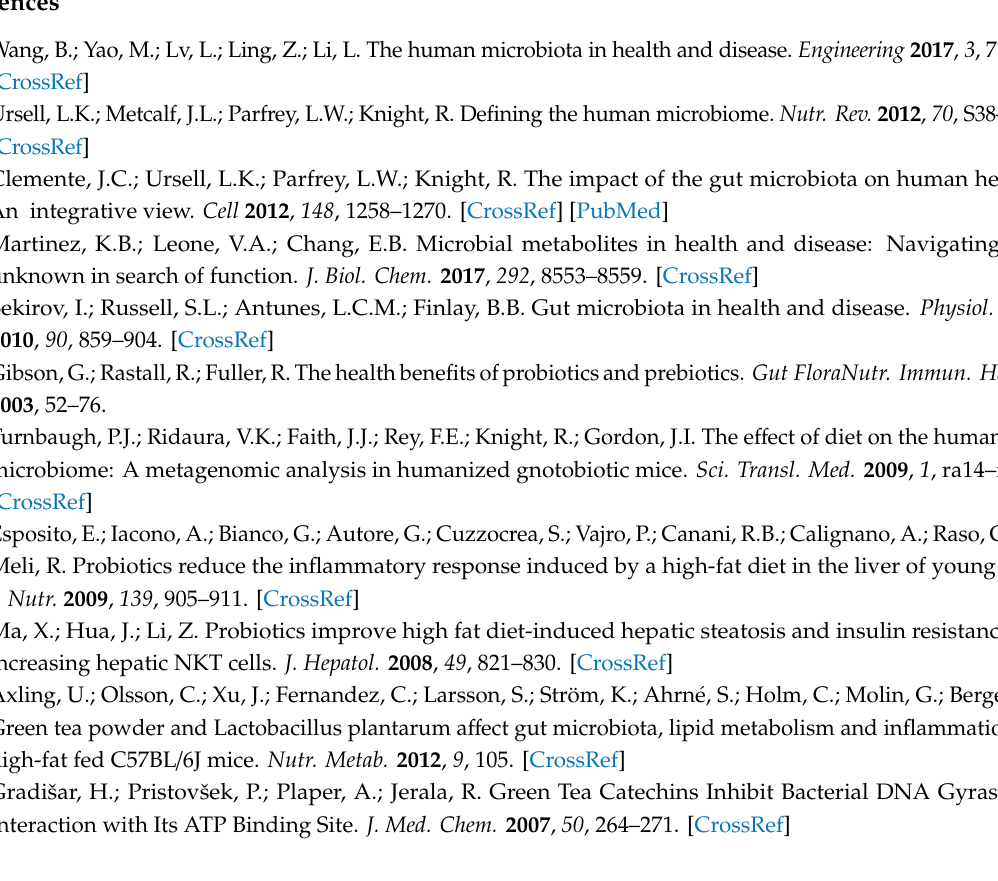
Supplementary Materials: The following are available online, Figure S1: The relative abundance of significant metabolites (ANOVA p -value < 1 × 10 − 10 ) that correlate with the genus in three vessels of HCM, Figure S2: Correlation analysis demonstrating the relationships between the significantly altered gut microbes and the detected microbial metabolites from the HCM study, Table S1: A list of one hundred and seventy-three detected metabolites reported in this study, Table S2. A list of seventy-seven metabolites form frequently investigated metabolic